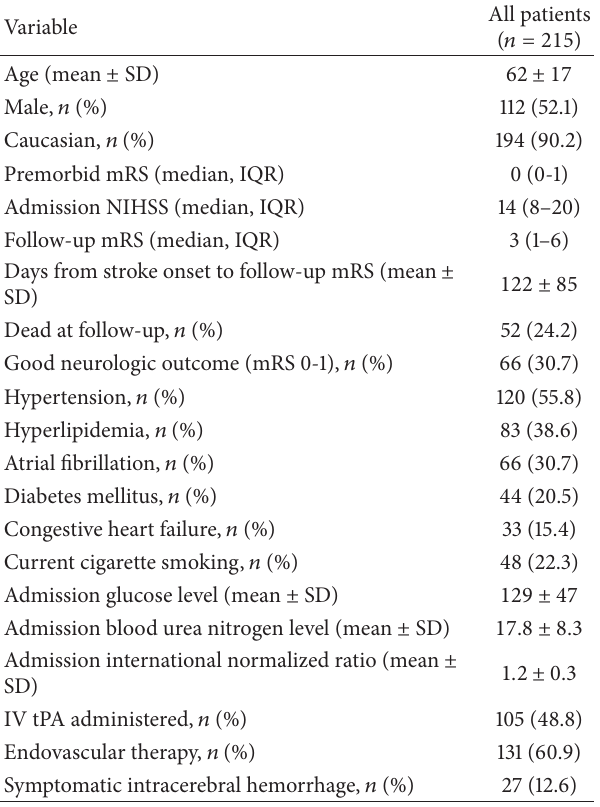
Table 1: Baseline demographics, imaging variables, laboratory values, and stroke risk